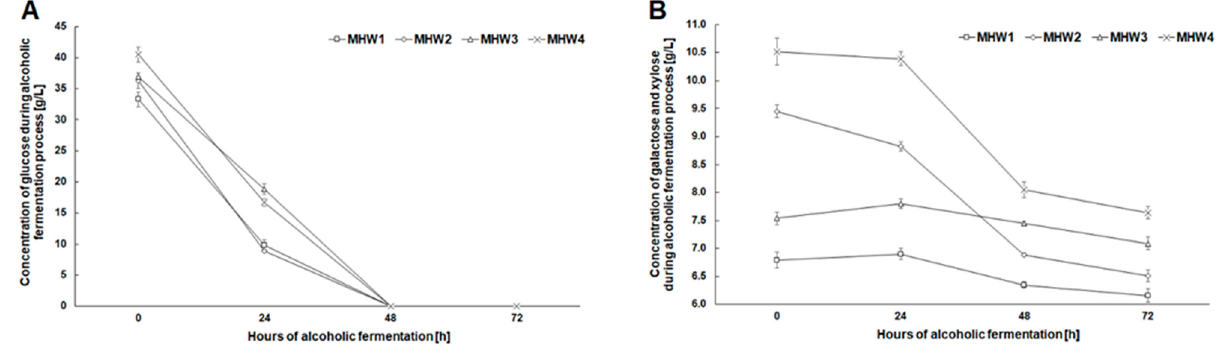
Figure 4. Changes in the concentration of glucose ( A ), and galactose and xylose ( B ) during alcoholic fermentation for wheat stillage concentrations 143 and 167 g/L after microwave-assisted pretreatment with NaCS.